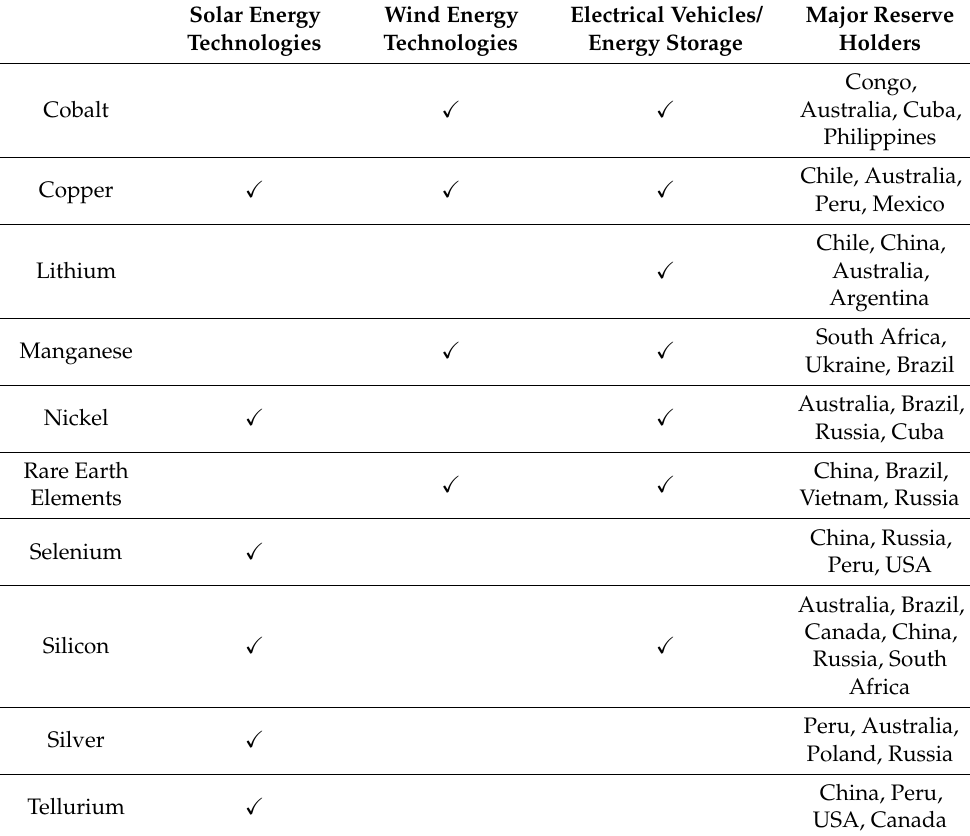
Table 1. Required raw materials for the production and consumption of clean energy